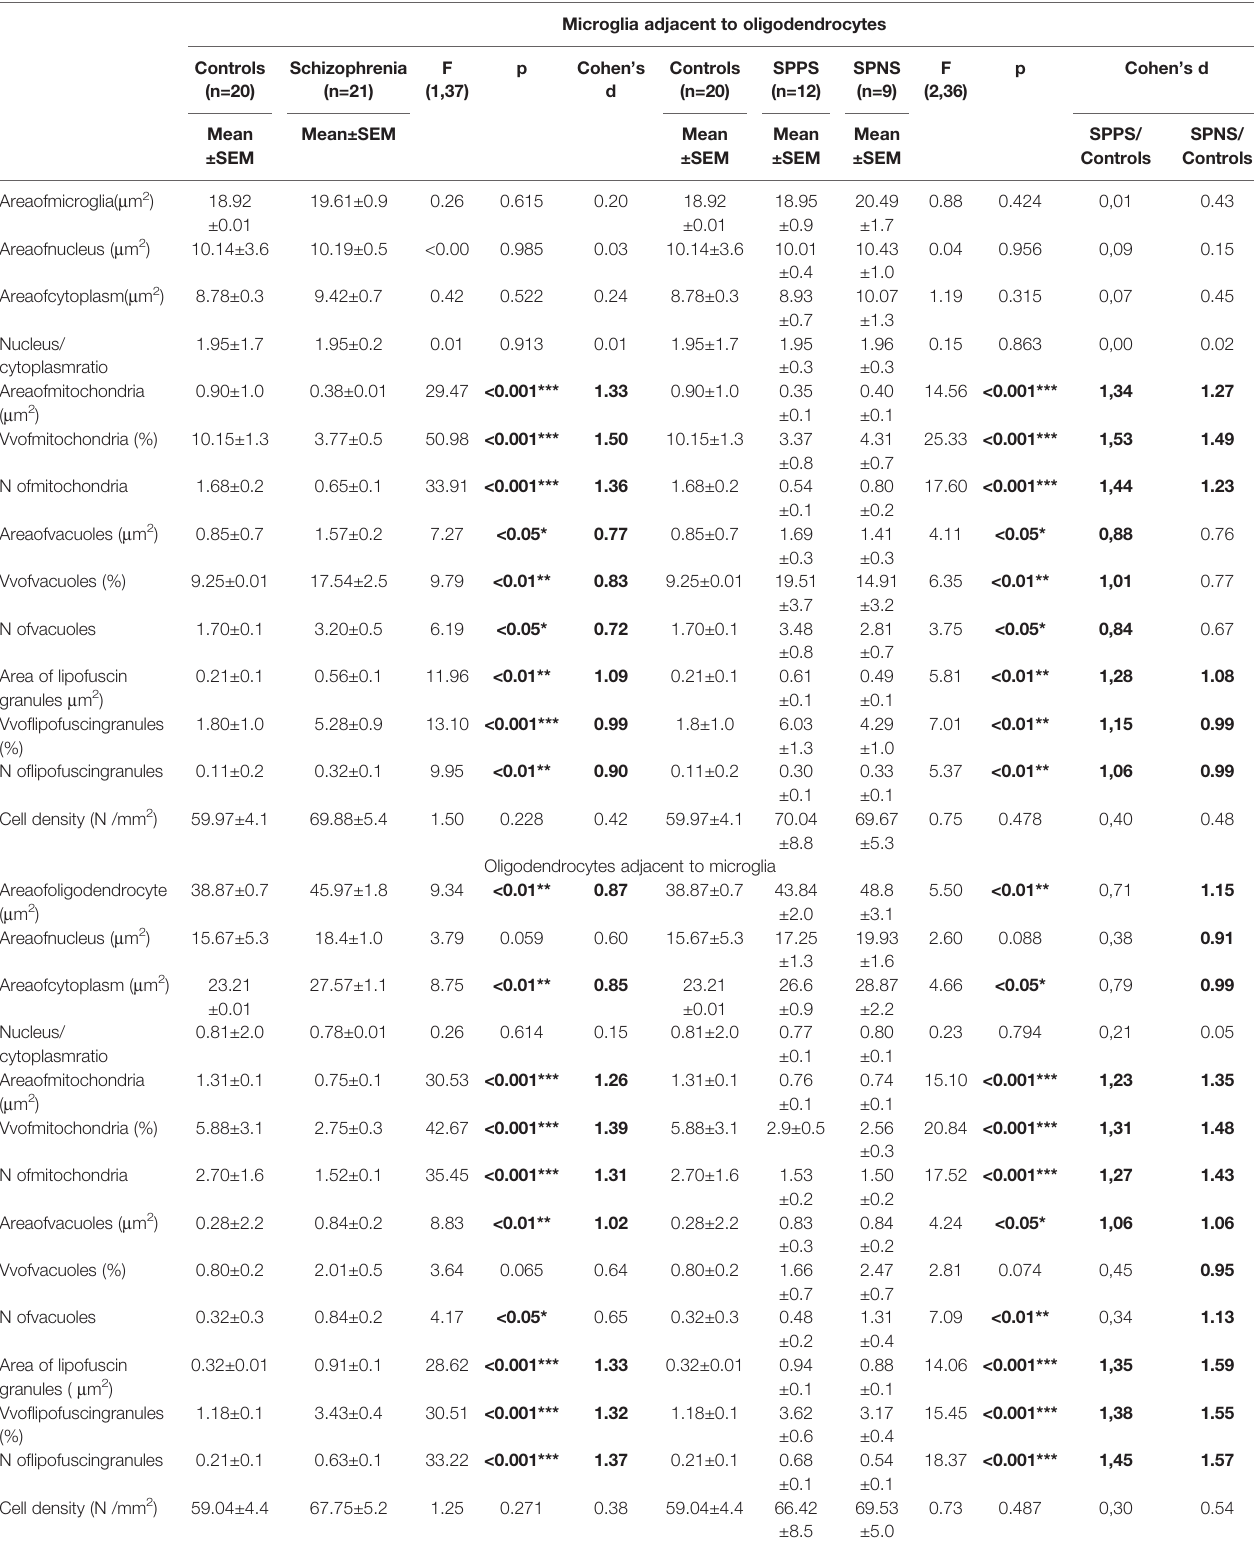
TABLE 2 | Effect of diagnosis on microglia adjacent to oligodendrocytes and on oligodendrocytes adjacent to microglia. Microglia adjacent to